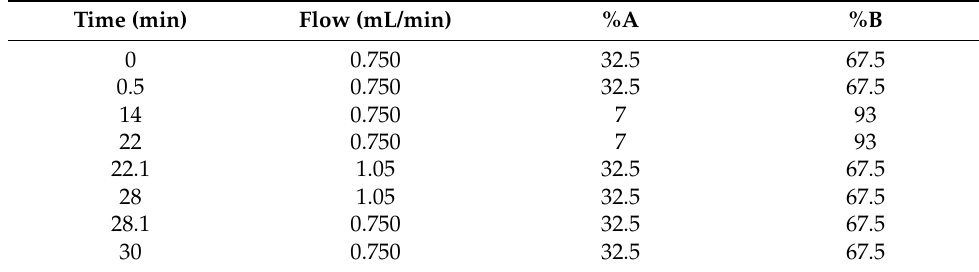
Table 5. Gradient elution of